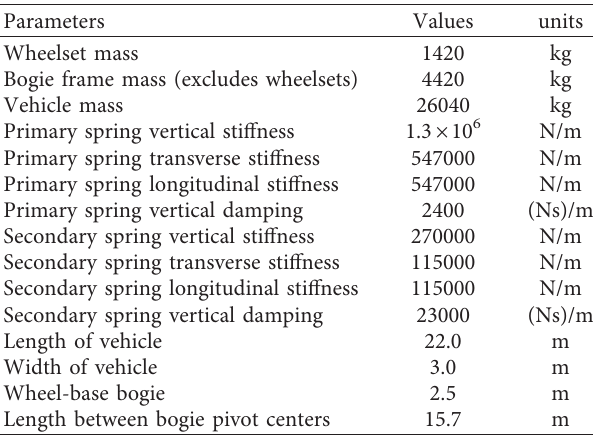
Figure 2: Picture of field measured corrugation. Table 2: Vehicle